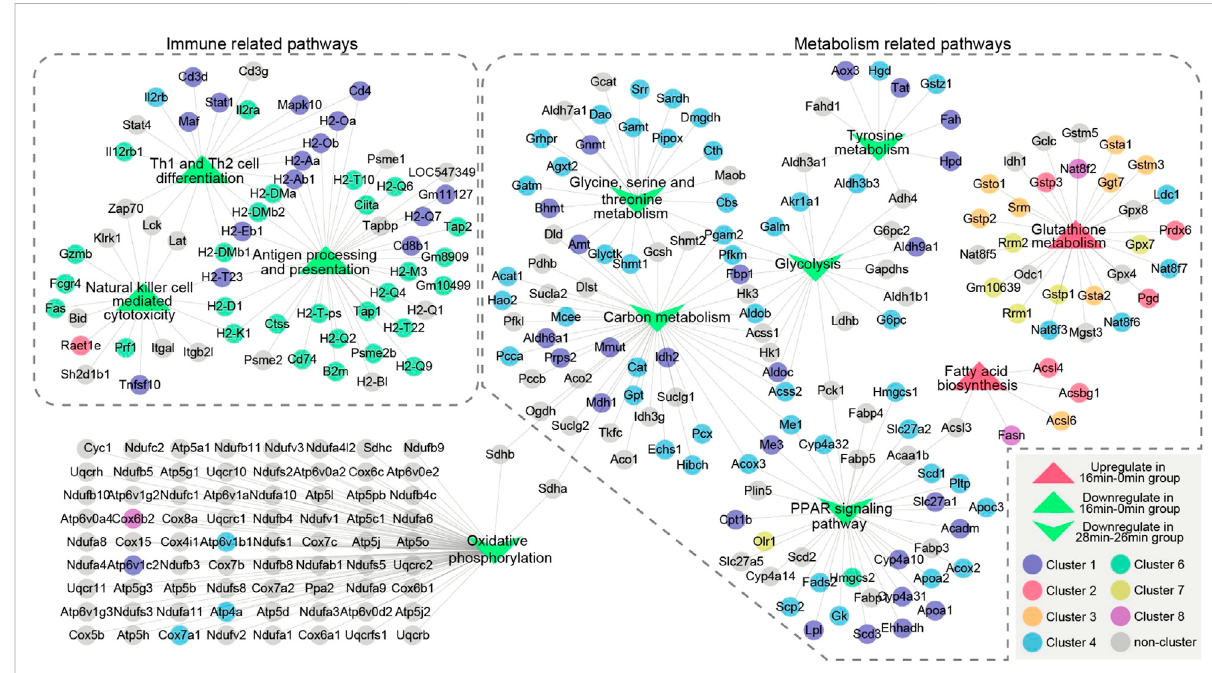
FIGURE 6 Therelationship ofunique enrichmentpathwaysinGSEAanalysis ofgenes in16 min – 0 min groupor28 min – 26 min group. Twodottedboxes representfunctionalmodulesofimmunerelatedpathwaysandmetabolismrelatedpathways.Thecirclesrepresentgenesandthetrianglesrepresent GSEA enrichment pathways. Different colors represent genes enriched in different clusters. Genes are connected based on the pathways they belong to. GSEA, gene set enrichment